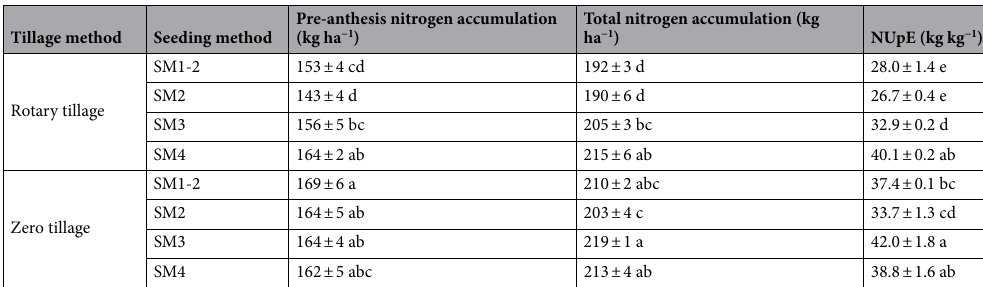
Table 7. The effects of tillage and seeding method combinations on (a) pre-anthesis and (b) total nitrogen accumulation and (c) nitrogen uptake efficiency (NUpE) in 2018. Data are presented as means ± standard errors. Different letters indicate significant differences between treatments at the 0.05 probability level. SM1-2 small-size drill seeder, SM2 small-size strip seeder, SM3 medium-size strip seeder, SM4 medium-size drill